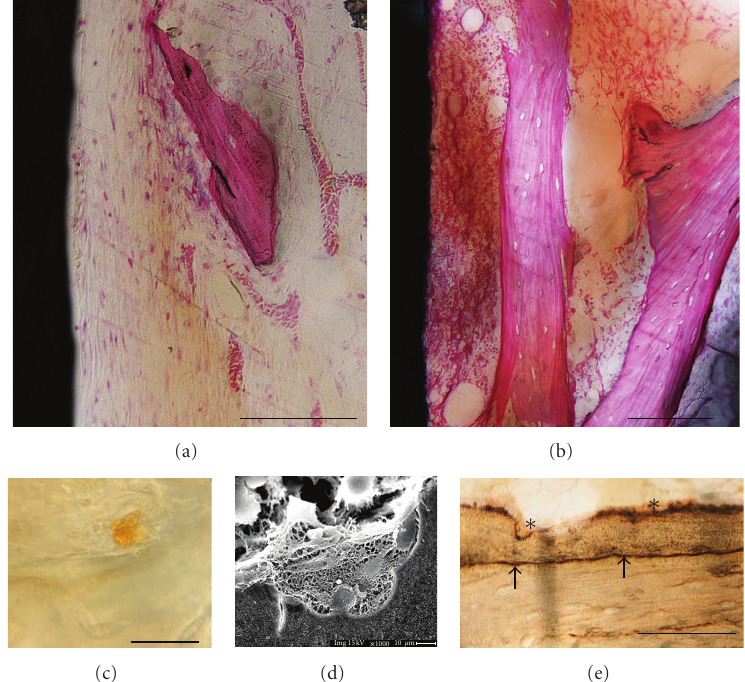
Figure 4: Day 3. Histology of longitudinal ground sections of MS (a) and SLA (b) surfaces. LM, toluidine blue, and acid fuchsin staining. Bar = 100 µ m. TRAP staining of osteoclast at the trabecular bone surface (c). Bar = 100 µ m. SEM images of resorption lacunae at the trabecular bone surface (d). ALP staining of osteoid rim at the trabecular bone surface (e). ALP positivity for bone areas facing the marrow cavity ( ∗ ); ALP positivity for the incremental line in close connection to the old bone (arrows). Bar = 100 µ